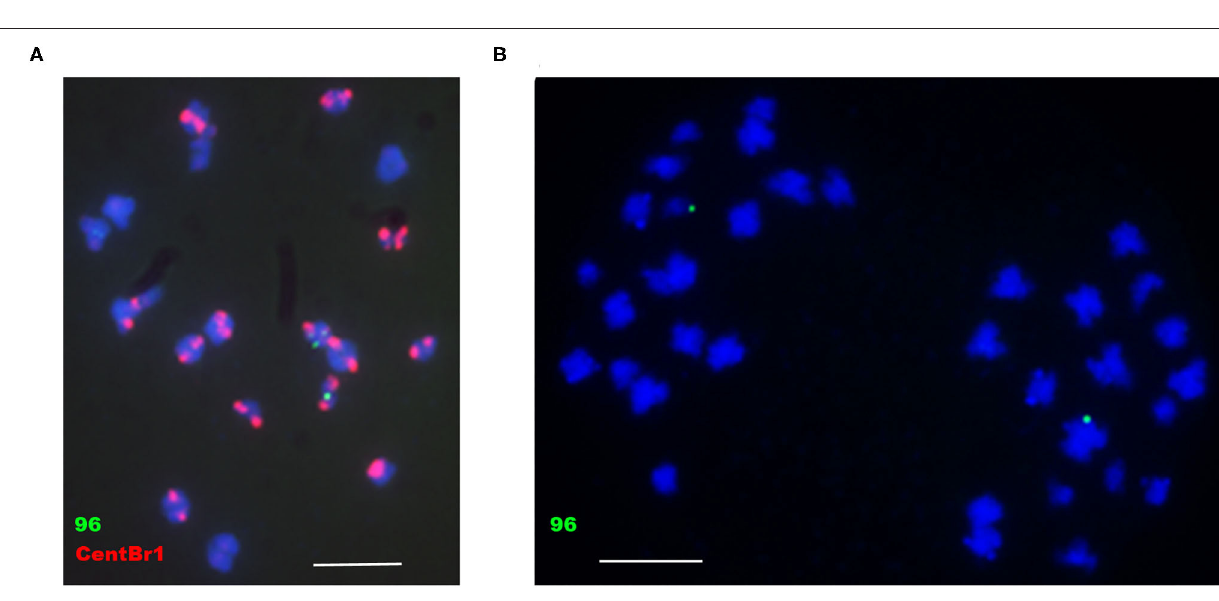
FIGURE 8 | Analysis of the behavior of minichromosomes in meiotic metaphase II and anaphase II by FISH. (A) 86-1-75-10-2, meiotic metaphase II; (B) 86-1-75-7-3, meiotic anaphase II. pWY96, green; CentBr1, red; DAPI, blue. Scale bar = 10 µ